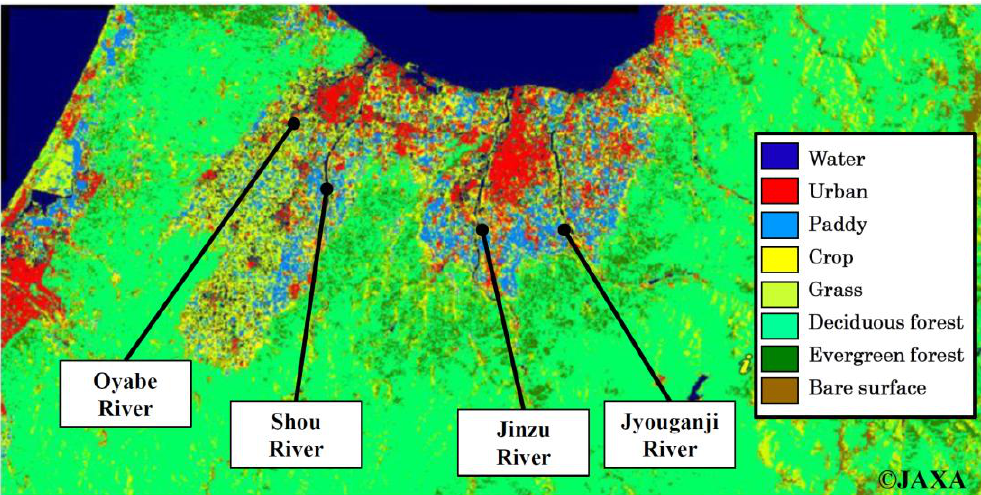
Figure 2. The land use management map for Toyama,